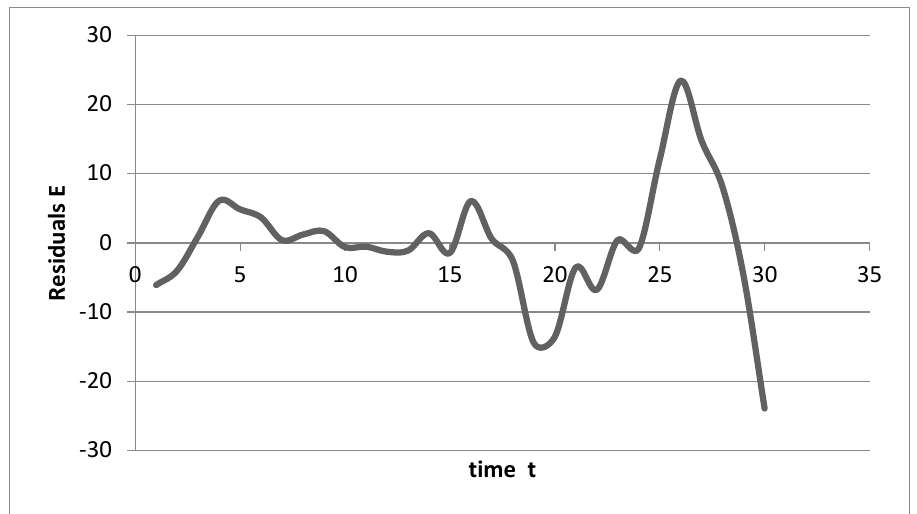
Figure 2. Second order polynomial residuals versus time intervals. Source: Table 1, reference [3], and authors’ calculations.